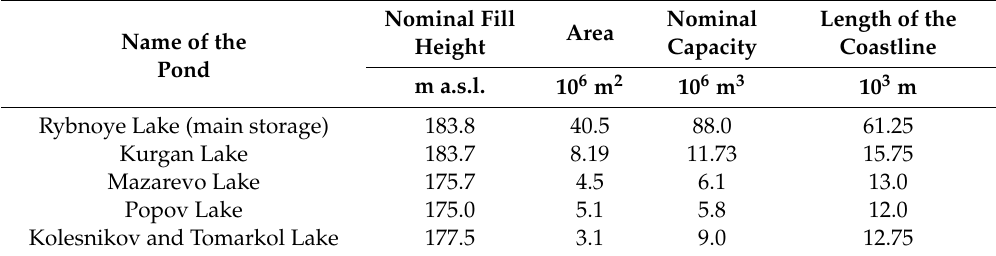
Table 1. Technical characteristics of sewage ponds serving Kostanay